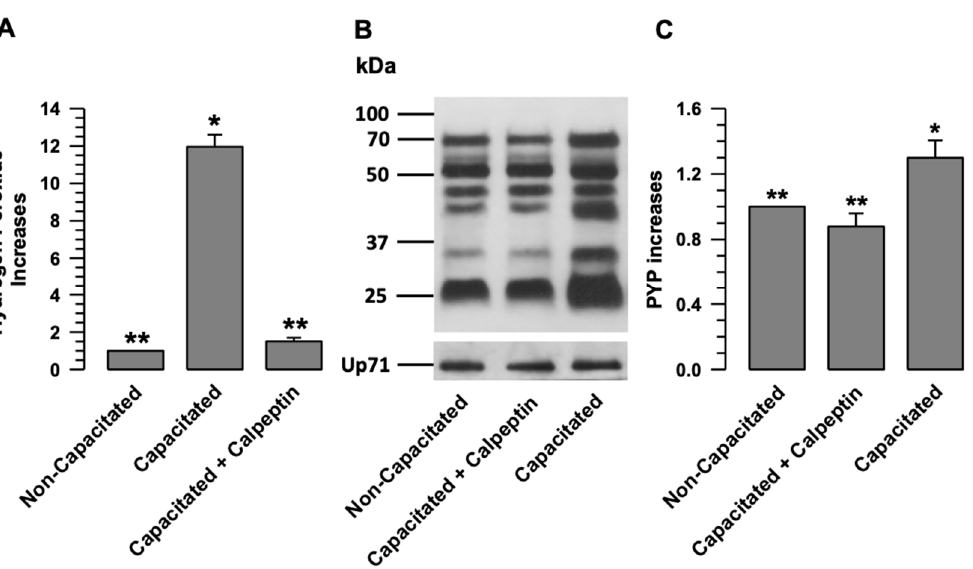
Figure 7. The activation of NOX2 and NOX4 depends on calpain activity. ( A ) H 2 O 2 production was assessed in non-capacitated or capacitated sperm in the absence and presence of calpeptin (Calp 10 µM). The results are expressed as the ratio N/N0, where N is the total amount of H 2 O 2 produced in each assay and N0 is the total quantity of H 2 O 2 produced by non-capacitated assay. The results are expressed as the mean ± S.E. ( n = 3). Differences were considered significant when p ≤ 0.05, comparing (*) concerning (**). ( B ) Determination of PYP patterns by immunoblotting of non-capacitated or capacitated sperm in the absence and presence of the calpain inhibitor calpeptin (Calp (10 µM)). Up71 was used as a loading control. The representative Wb image of three independent experiments for PYP is shown. ( C ) The results are expressed as the ratio N/N0, where N is the total amount of PYP and N0 is the total PYP quantity of non-capacitated assay. Results are expressed as the mean ± S.E. ( n = 3). Differences were considered significant when p ≤ 0.05, comparing (*) concerning (**).